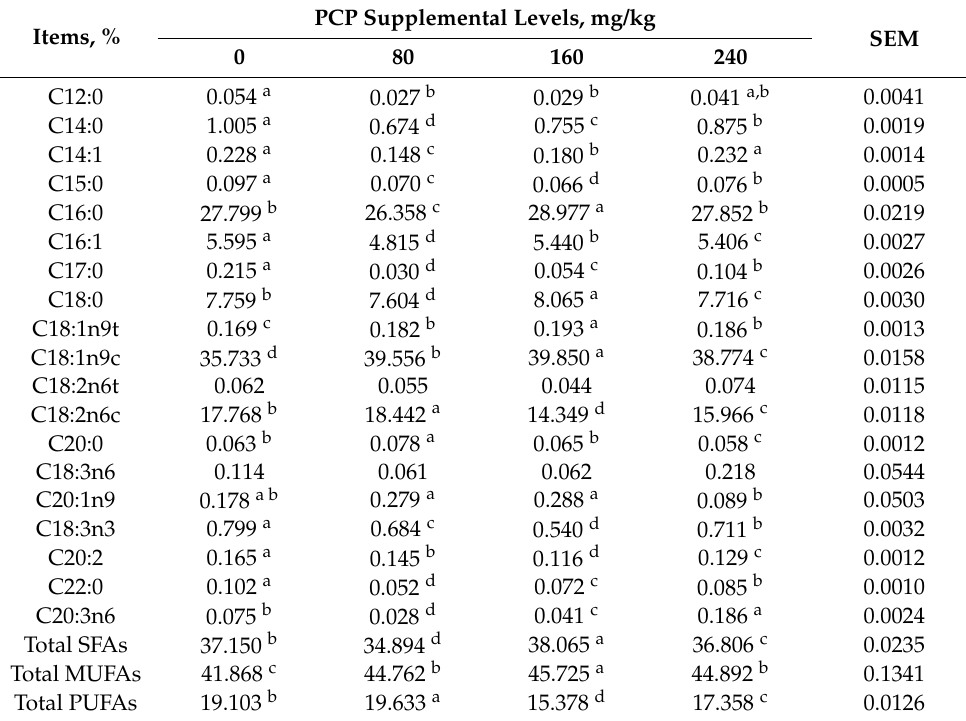
Table 6. Effect of anthocyanin-rich PCP on fatty acid of growing chickens. PCP Supplemental Levels, Items, %